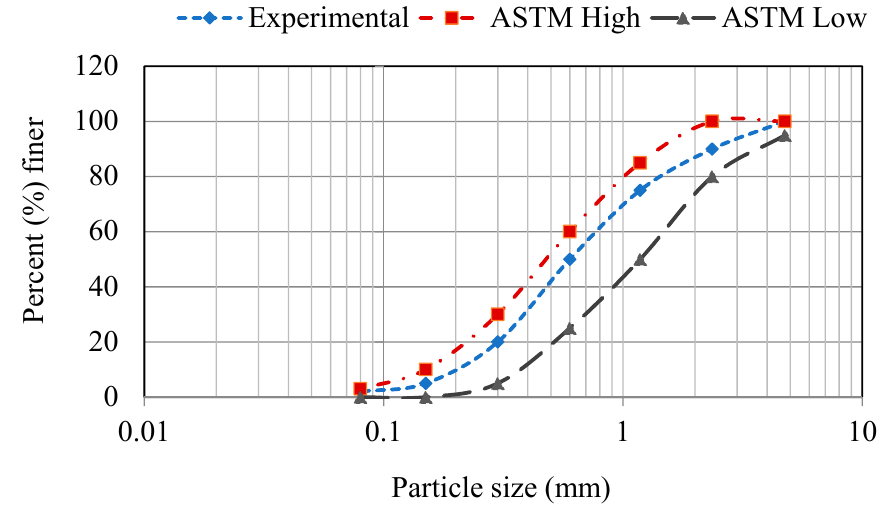
Figure 1. Gradation curves for fine aggregate and ASTM C33 (American Society for Testing and Materials) grading requirements.